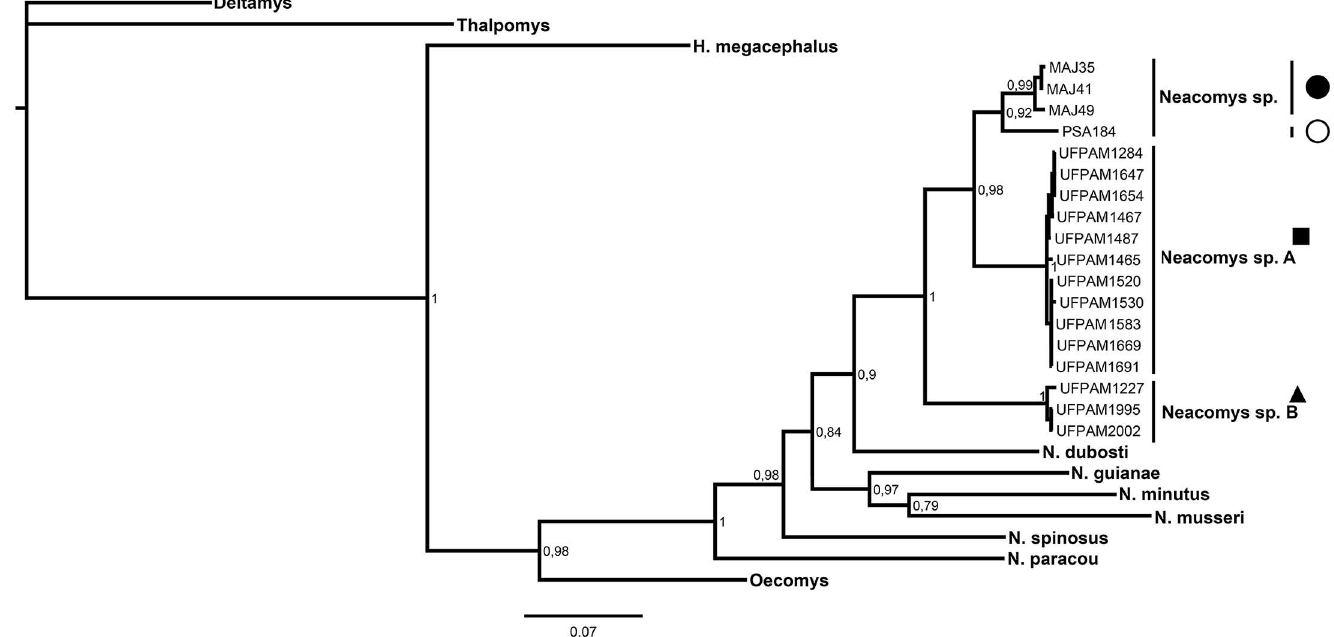
Fig 6. Bayesianinference chronogram from BEAST estimated based on haplotypes from 58 sequences of the concatenated mitochondrial genes (COI and Cytb). The Bayesian posterior probability(BPP) is given at each node (BS/BPP). The symbols refer to species mentioned in Fig 1. Legend: black square( Neacomys sp. A), black triangle( Neacomys sp. B), white circle ( Neacomys sp. from Maraba´) and black circle ( Neacomys sp. from Marajo´ island) [28].